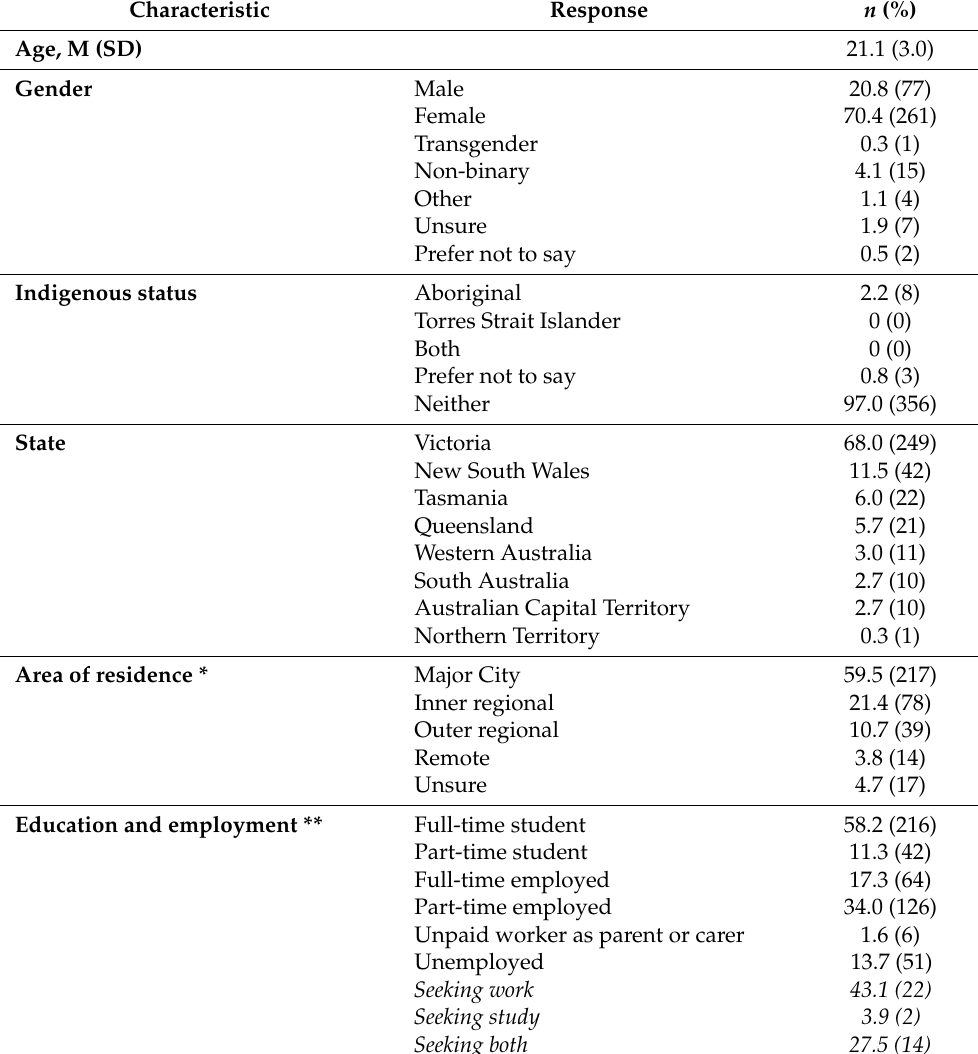
Table 1. Demographic characteristics of the